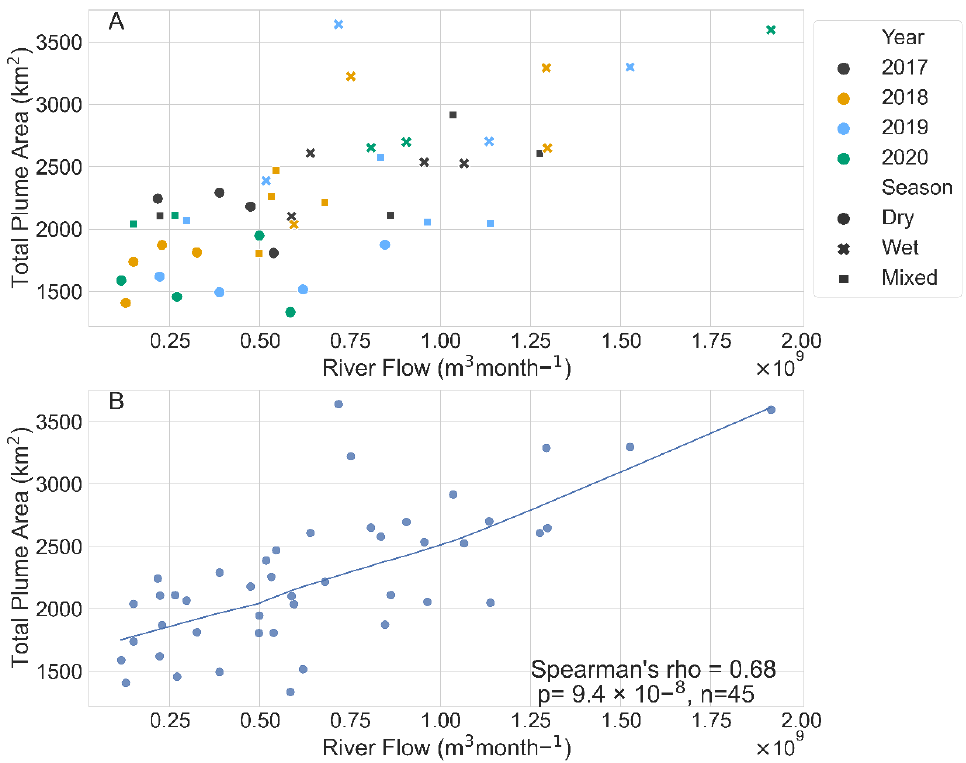
Figure 9. Variability in the river flow and the plume across years and season ( A ). Spearman’s correlation coefficient (ρ/rho) ( B ) calculated between the river flow and the plume using all the available data between 2017 – 2020 (n = 45). The blue line shows the local regression fit.